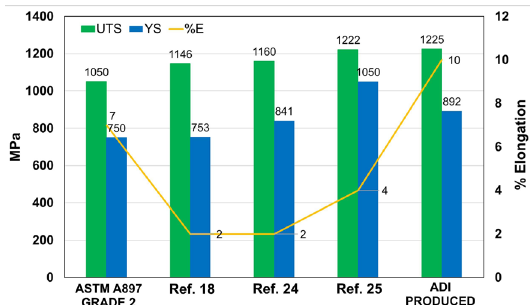
Figure 8. Comparison of mechanical properties of the ADI produced, three reports from the literature 18,24,25 , and requirements of ASTM A897/897M – 16 Grade 2.